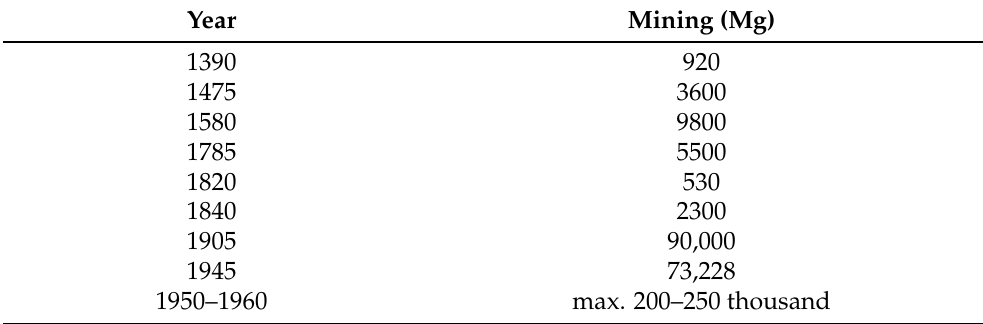
Table 3. Size of iron ore mining in Czestochowa Ore-bearing Area over the years (based on [3]).